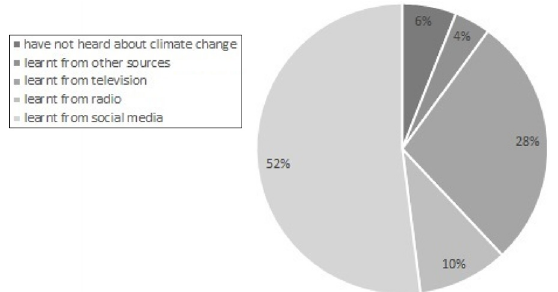
Figure 3. Knowledge and common sources